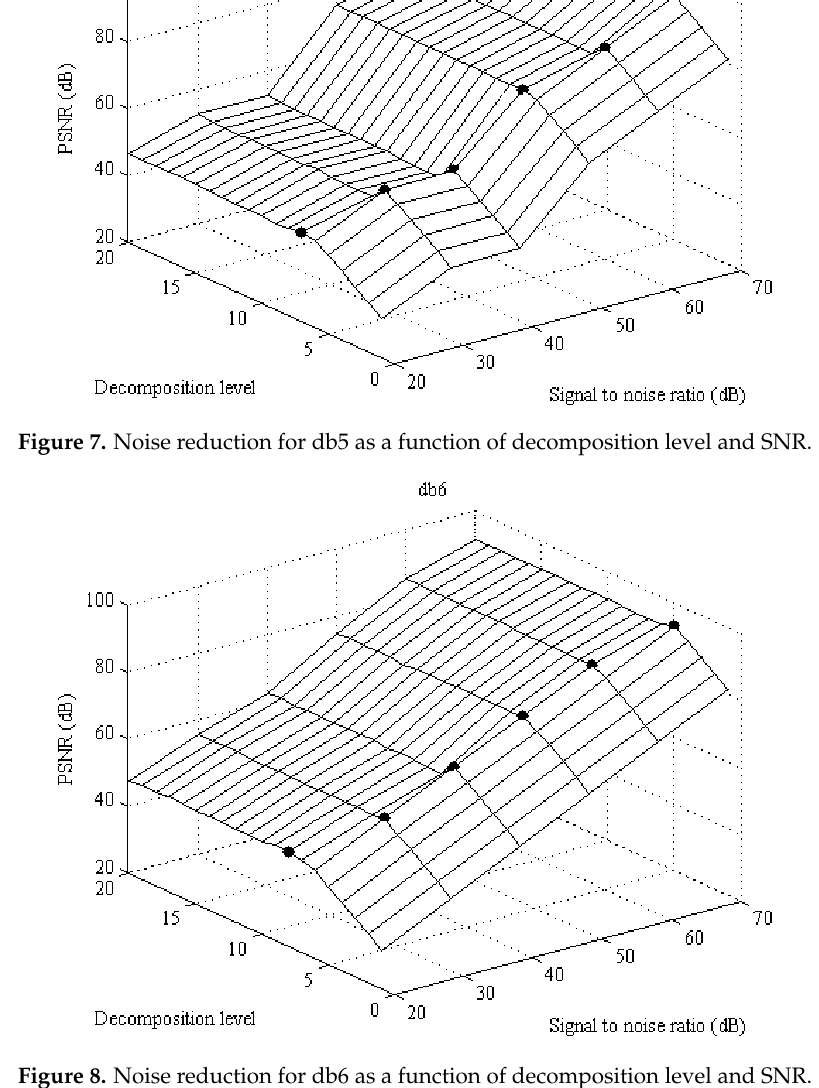
Figure 7. Noise reduction for db5 as a function of decomposition level and SNR.